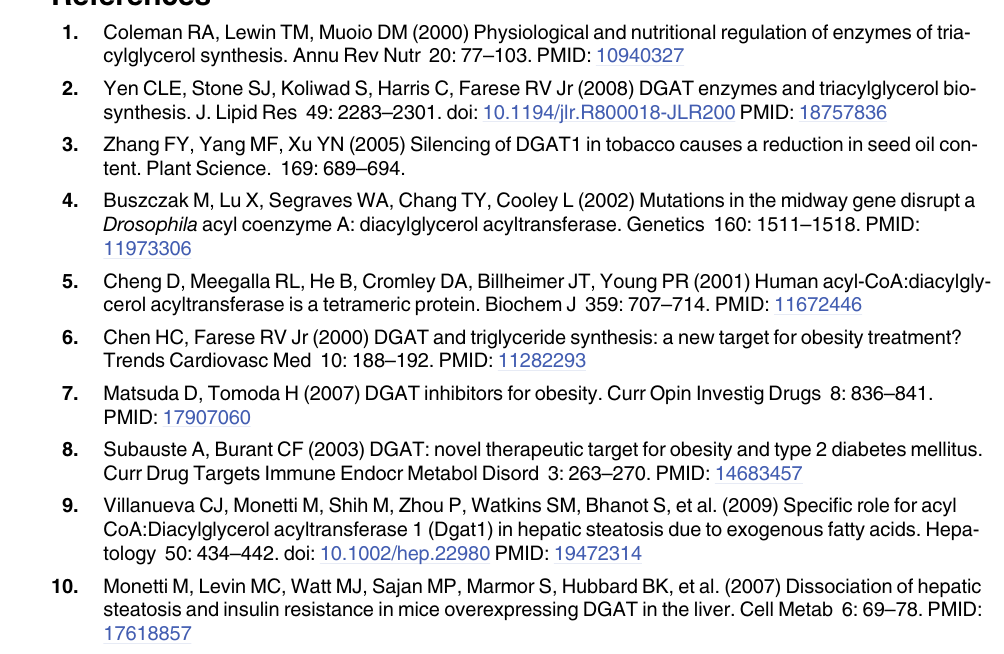
S3 Fig. Interactions of the Sit1 peptide with LUVs. a) CD spectra of Sit1 in water (black) or with LUVs of DPPS (dash), POPC (dot), POPA (grey), DPPG (dash dot grey), and POPG (dash dot dot grey). b) Fluorescence spectra of Sit1 (bold) in water or with LUVs of DPPS (dash), POPC (dot), POPA (grey), DPPG (dash dot grey), and POPG (dash dot dot grey). (TIF) S4 Fig. Interactions of the Sit1&2 peptide with LUVs. a) CD spectra of Sit1&2 in water (black) or with LUVs of POPC (dash), POPE (dot), POPA (grey) and POPG (dash dot grey). b) Emission spectra of Sit1&2 in water (black) or with LUVs of POPC (dash), POPE (dot), POPA (grey) and POPG (dash dot grey). (TIF) S5 Fig. Release of the internal contents from POPG liposomes. The addition of increasing amounts of a) Sit1 (8, 16, 32, 32, and 64 μ M) and b) Sit2 (0.125, 0.25, 0.5, 1, 2, 4, and 6 μ M) gradually disturbs the liposome integrity. The arrows indicate the additions of peptide, and the bold curve is following addition of Triton-10% detergent (after 10 min incubation), which completely disrupts the bilayer.